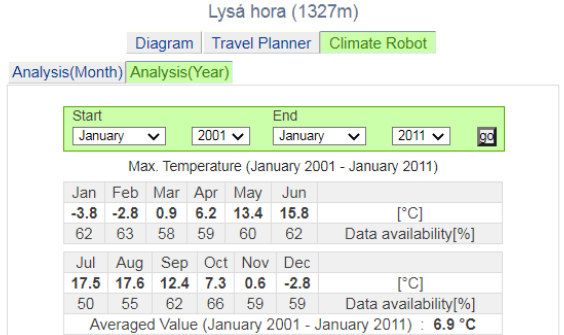
Figure 6. Calculation of the average outdoor temperature in Scenario 1 [18].